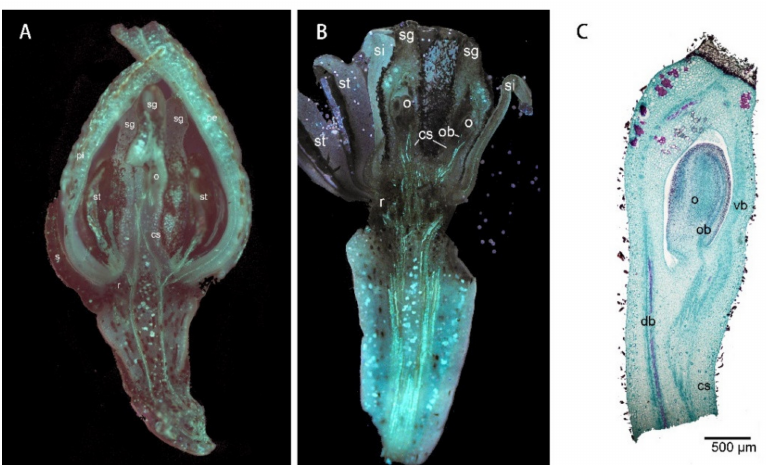
Figure A1. Longitudinal sections of Anaxagorea flower and carpel. ( A ) Longitudinal section of the flower of Anaxagorea luzonensis . ( B ) Longitudinal section of the flower (without perianth) of Anaxagorea javanica . ( C ) Longitudinal section of the carpel of A. Javanica . Db, dorsal bundle; cs, carpel stipe; o, ovule; ob, ovule bundle; pe, outer petal; pi, inner petal; r, receptacle; s, sepal; st, stamen; si, staminode; sg, stigma; vb, ventral